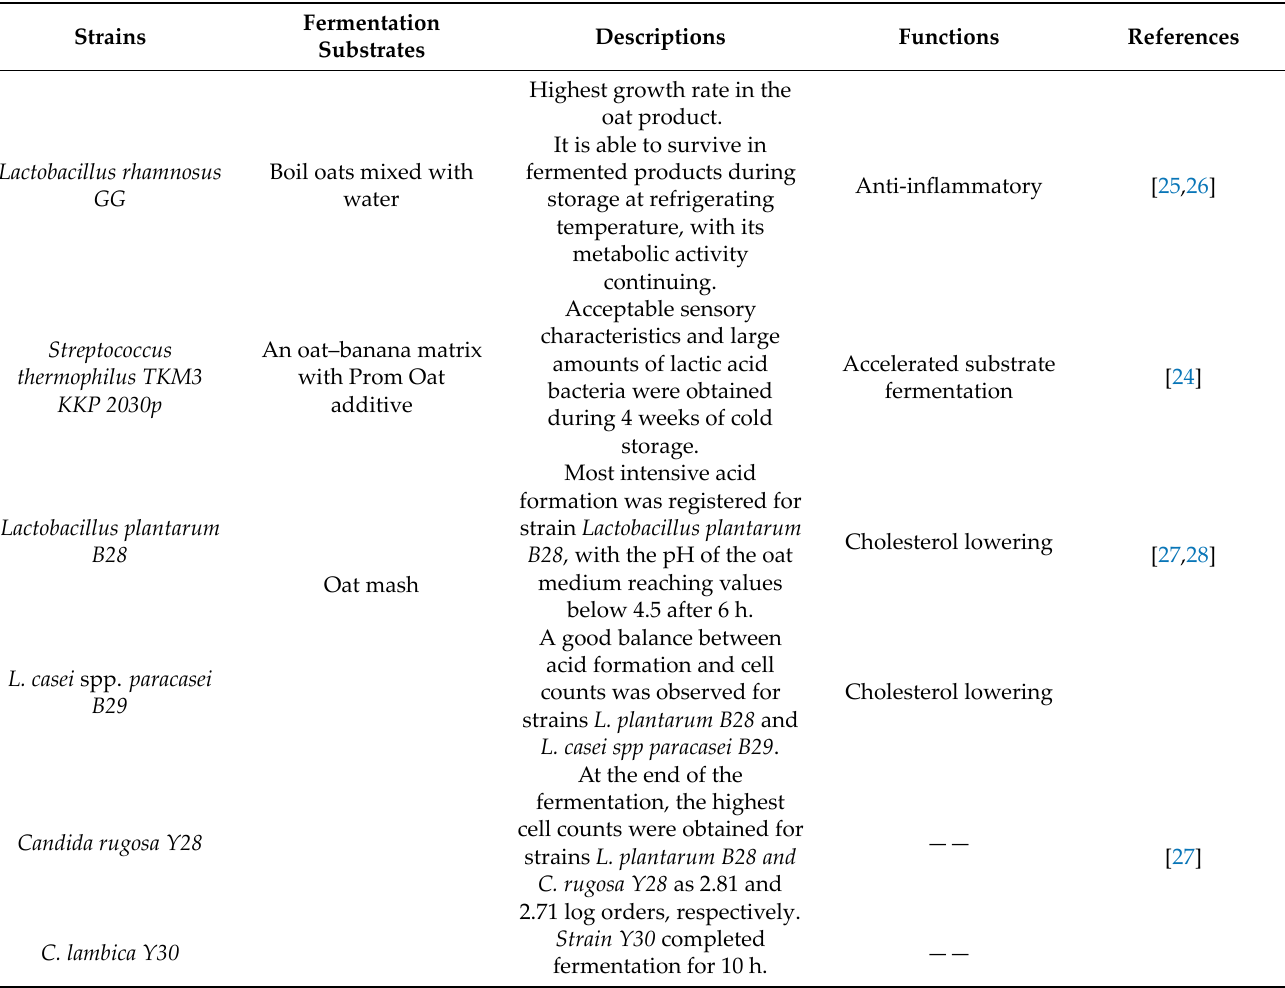
Table 1. Progress in the study of applicable strains of fermented oats and their potential